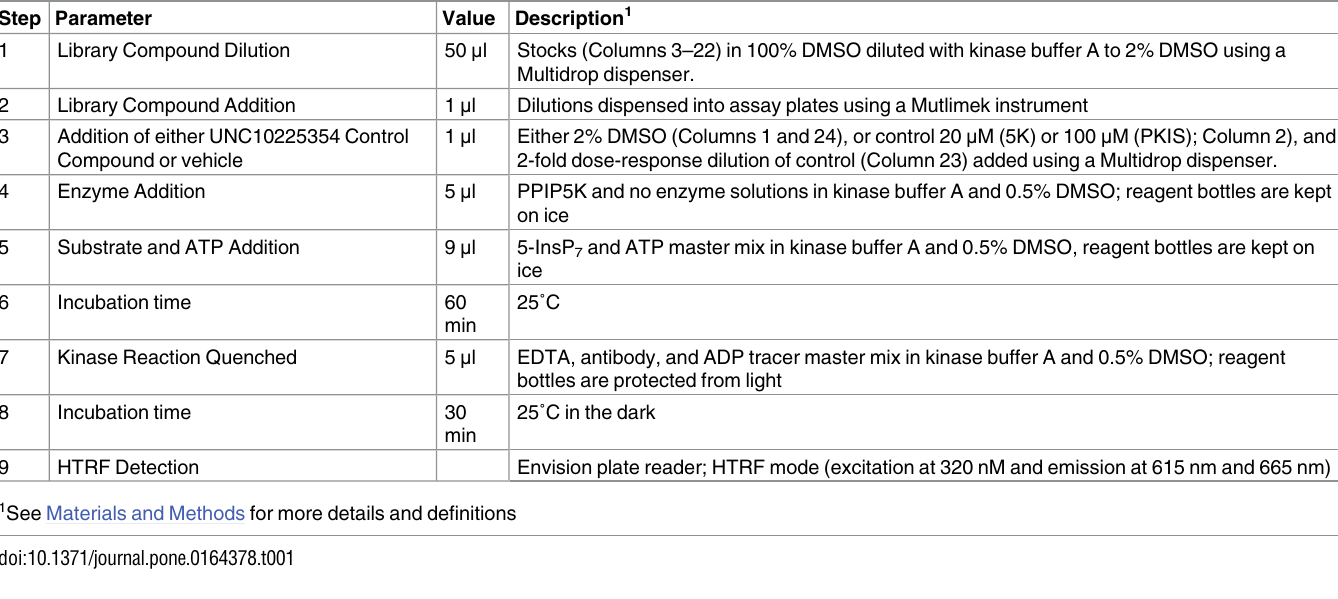
Table 1. Steps of the PPIP5K HTS Assay.